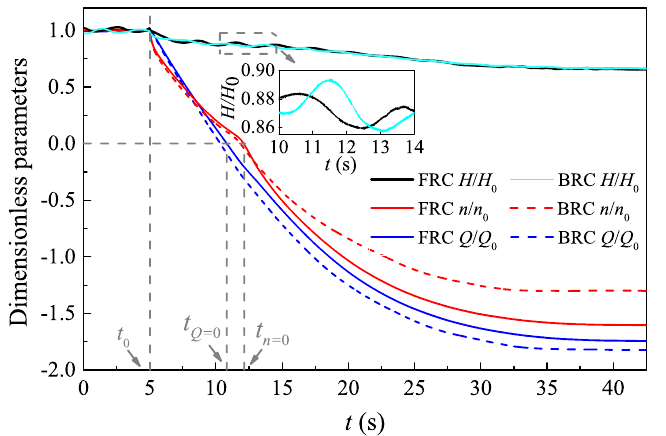
Figure 7. External characteristic curve under FRC and BRC.